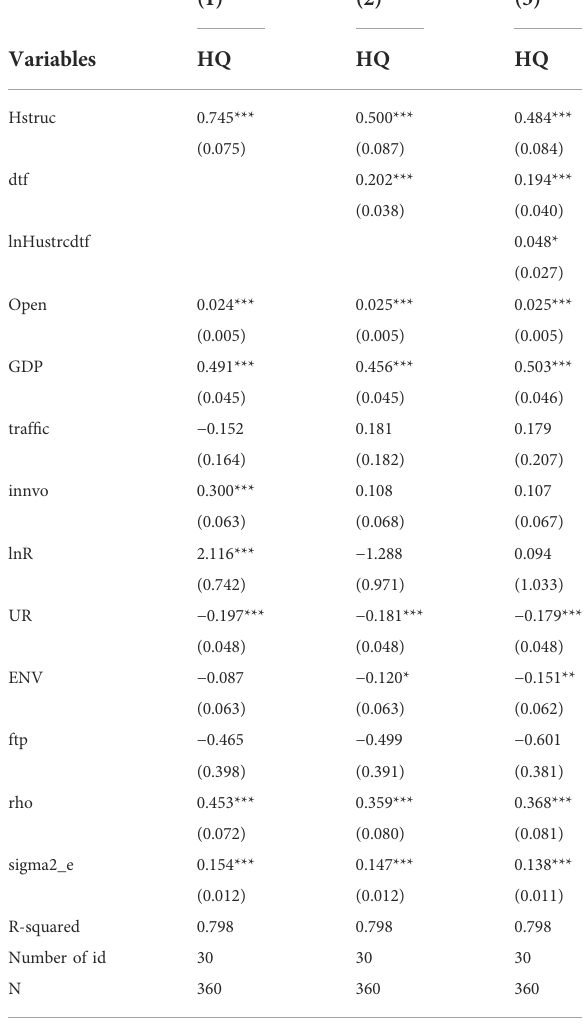
TABLE 8 Results of the spatial Durbin